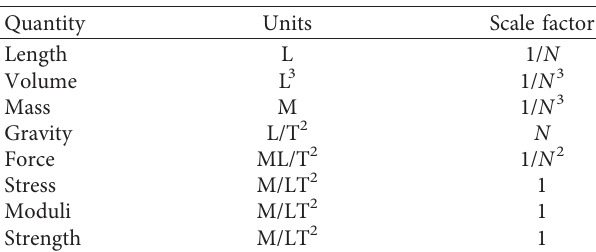
Figure 15: Normalized soil plug resistance with one-hole re- striction plates of different inner hole diameters ( D � 10cm and L / D � 4.0). Table 4: Scale factors for geotechnical centrifuge modeling.